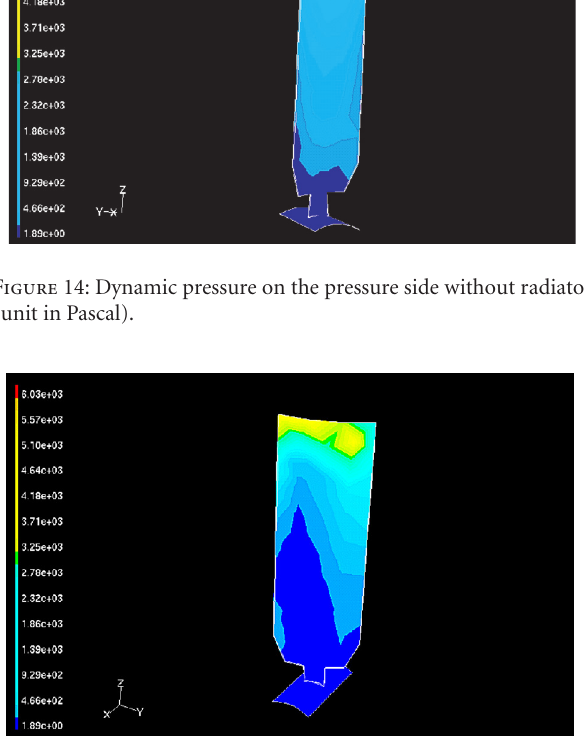
Figure 17: Total pressure on the pressure side and top face of the domain without radiator (unit in Pascal).